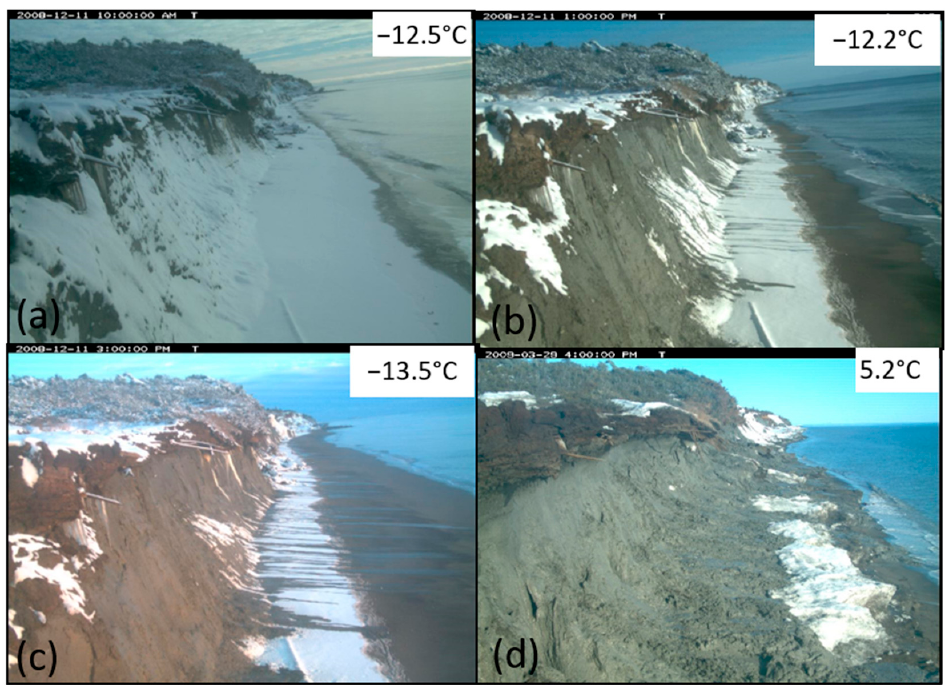
Figure 14. Impact of solar radiation on the triggering of solifluction: ( a – c ), 11 December 2008 at 10:00, 13:00. and 15:00 respectively; ( d ) 29 March 2009, active thawing and solifluction on the whole cliff. The sediments cover the ice-foot.